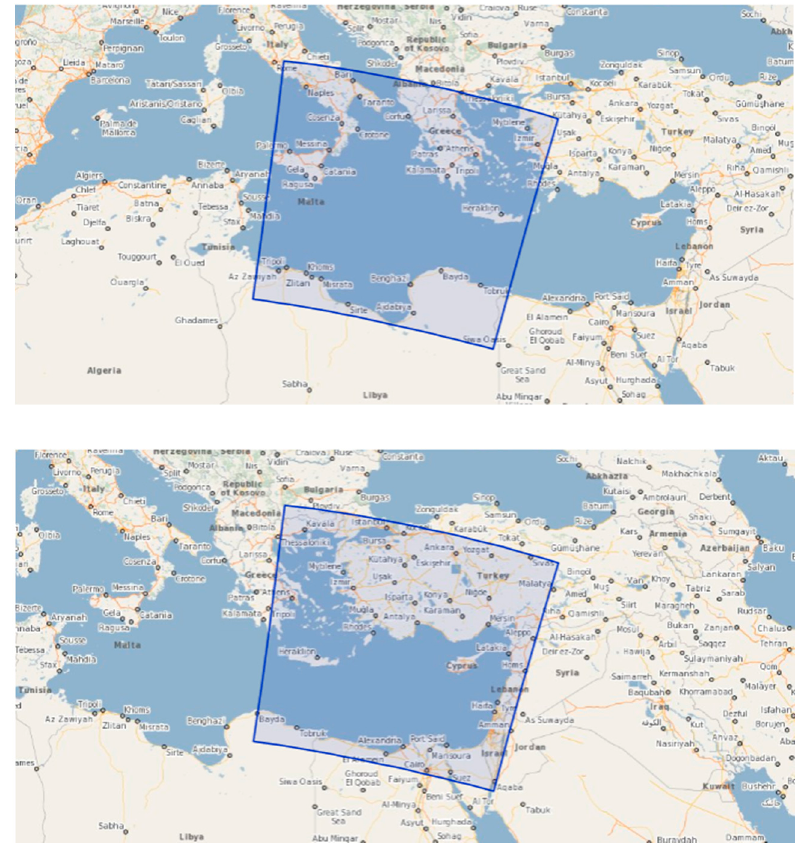
Figure 4. The footprint of Sentinel-3B OLCI Pass No. 278 ( upper ) and No. 135 ( lower image ) contains the entire island of Crete and thus these have been chosen to be used in the present investigation.